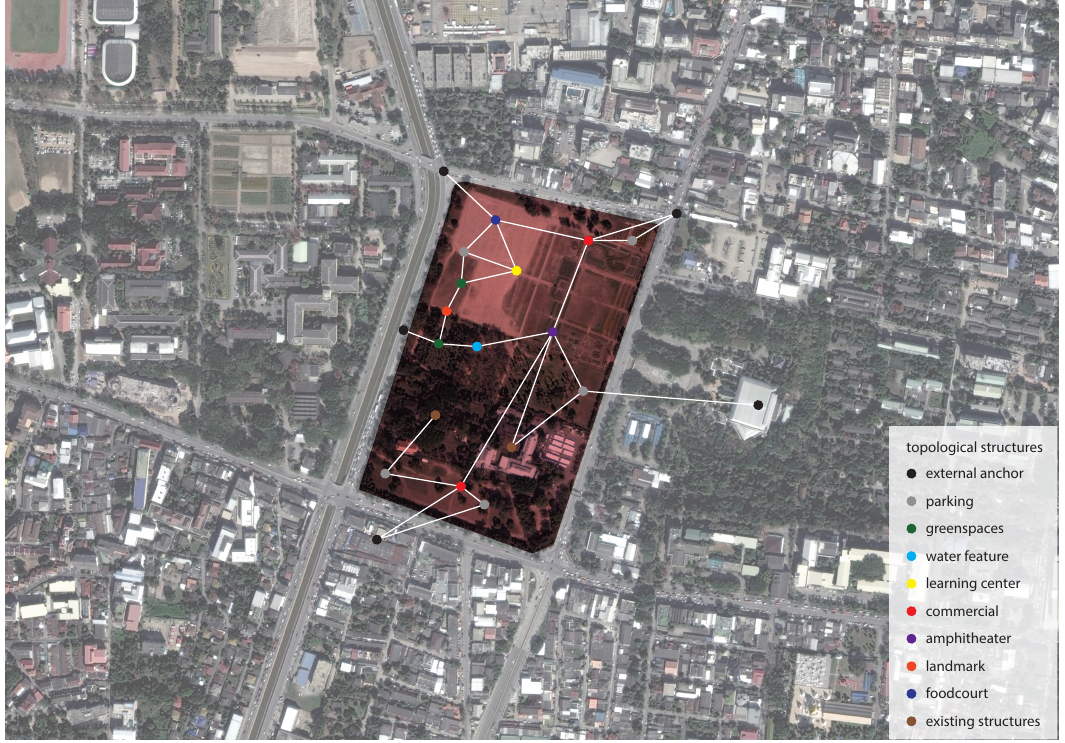
Figure 2. The graph G which reflects the facilities and their connection. The figure is adapted from Google R (cid:13) map. meant the connected parts between two facilities as shown in Fig- that the area for allocation is a convex polygon written as P ure 2 where the shaded area is the area for allocation. We assume